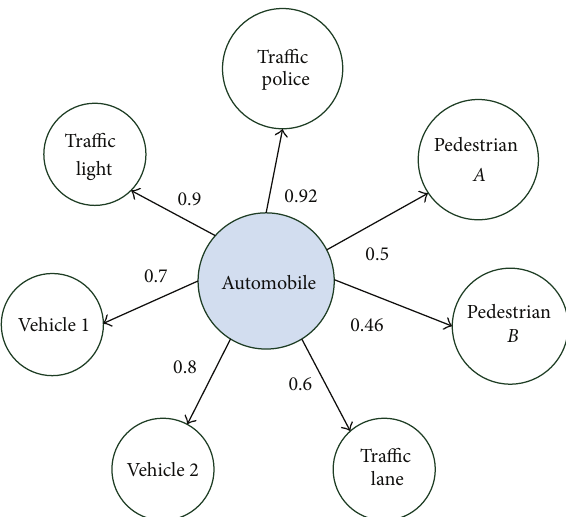
Figure 2: The knowledge cluster formed with an automobile as